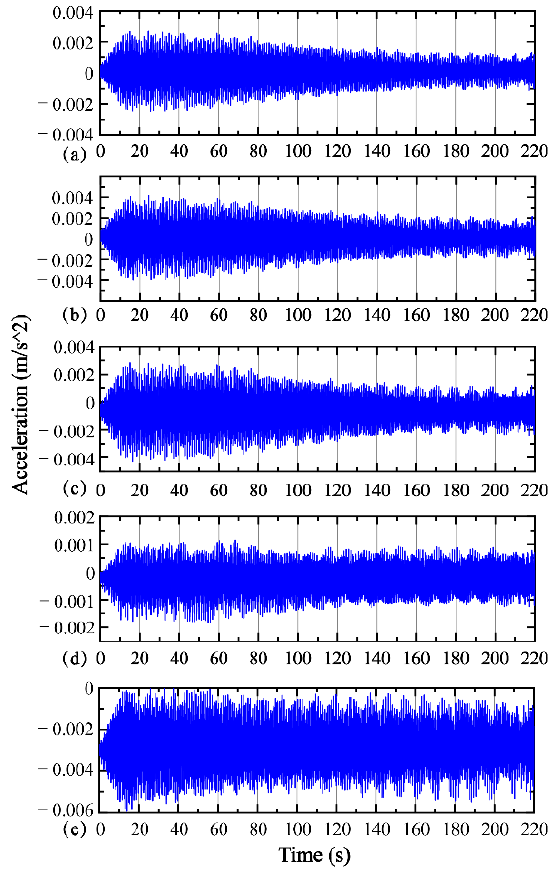
Figure 5. Acceleration of the cables by ( a ) Sensor 1, ( b ) Sensor 2, ( c ) Sensor 3, ( d ) Sensor 4, and ( e ) Sensor 5.